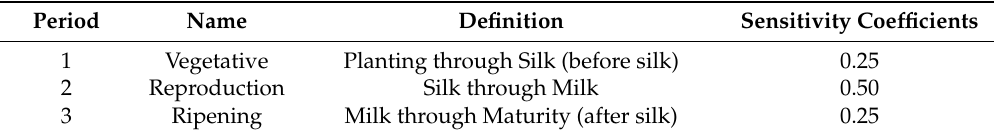
Table 2. Corn phenology stages with corresponding water-stress sensitivity